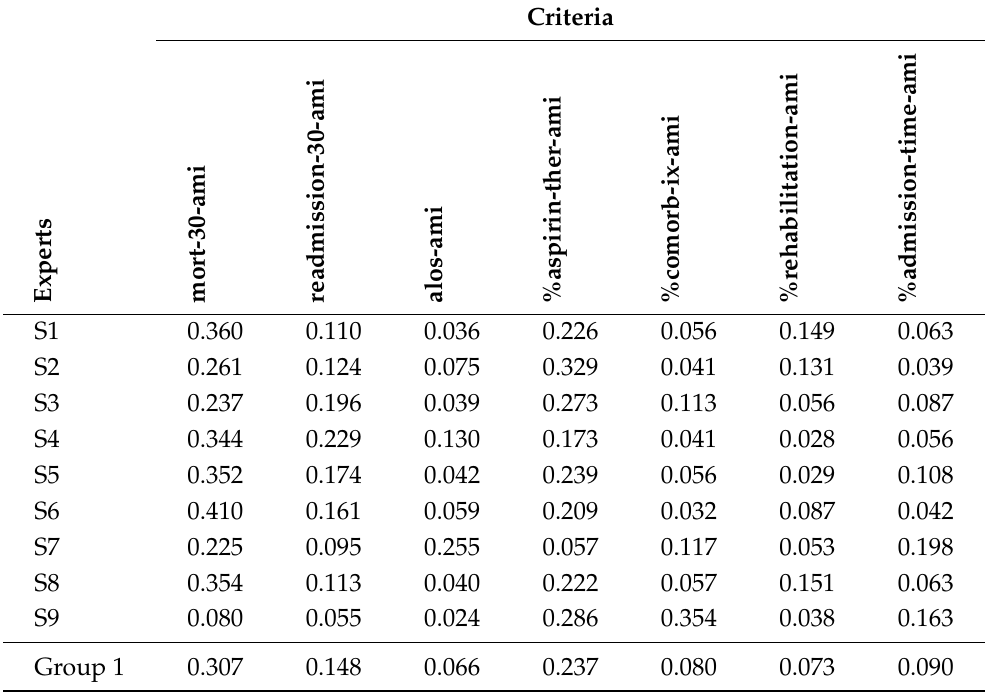
Table 5. AMI criteria weights based on individual comparison matrices, and the group criteria weights. (S1 to S9 indicate experts participating in the AHP